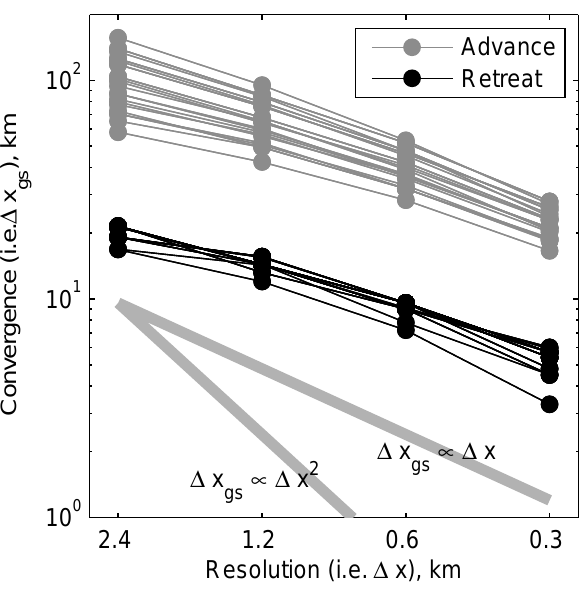
Fig. 8. Convergence of steady state grounding line position (de- scribed in Sect. 4.1). 1x gs is plotted against resolution for all GLPs (see Table 1). Example first order and second order convergence (grey bars) are shown for comparison.